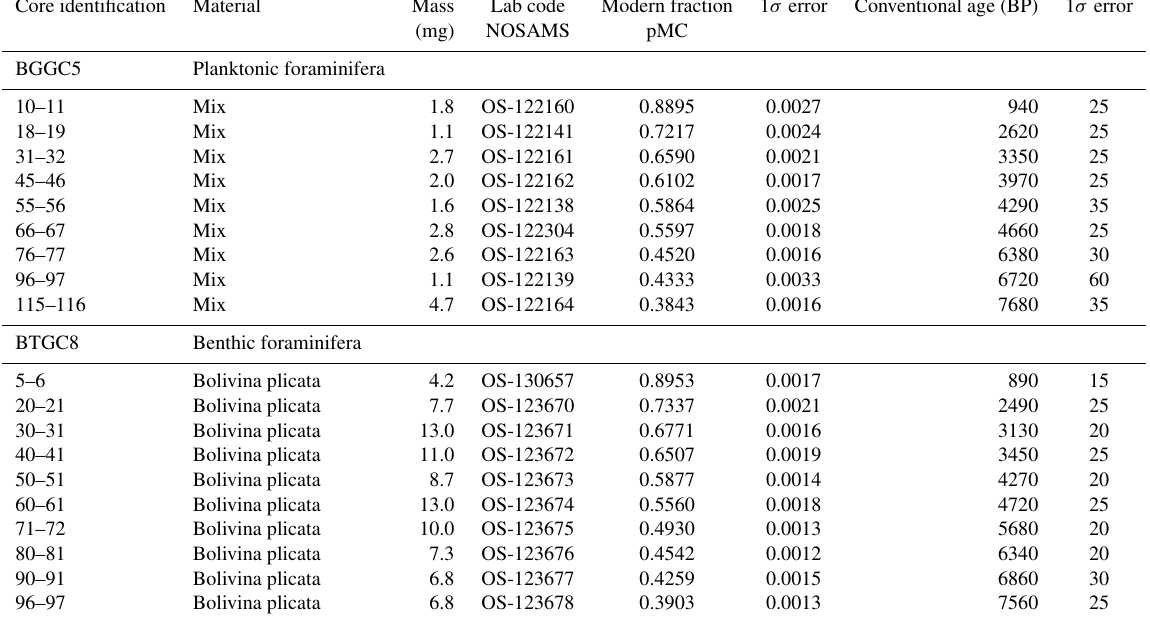
Table 1. Radiocarbon dates for BGGC5 and BTGC8 sediment cores collected from mixed planktonic foraminifera and monospecific ben- thic foraminifera ( Bolivina plicata ), respectively. The 14 C-AMS was performed at NOSAMS-WHOI. The lab code and conventional ages collected from each core section are indicated. For error calculations see http://www.whoi.edu/nosams/radiocarbon-data-calculations (last access: 5 November